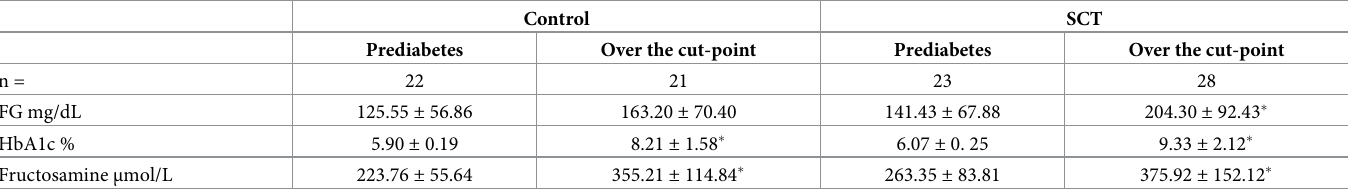
Table 4. Average fasting glucose, HbA1c, and fructosamine in subjects classified as having prediabetes and subjects classified as over the clinical cut point in the control and SCT